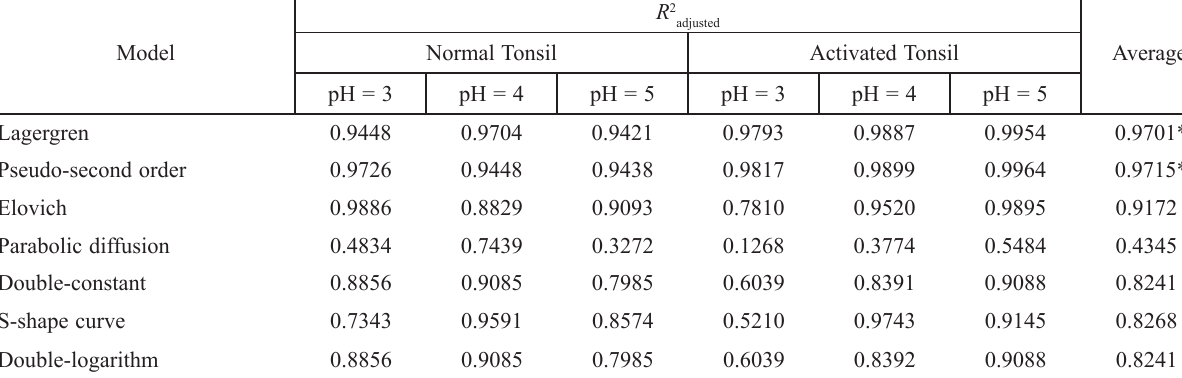
Table 4 – R 2 criterion for the sorption of Zn on Tonsil adjusted